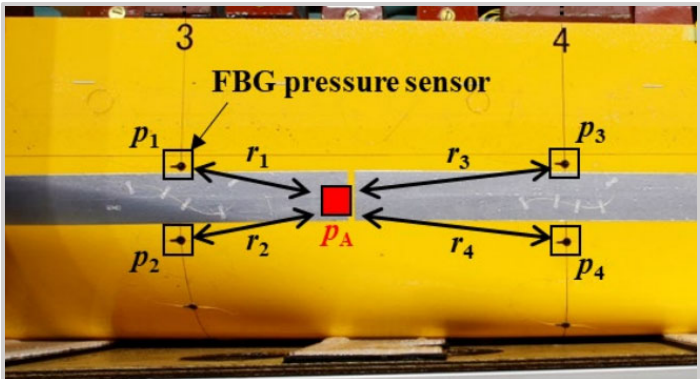
Figure 9. Hull structural strength evaluation using FBG pressure sensors. Reprinted with permis ‐ sion from [138].